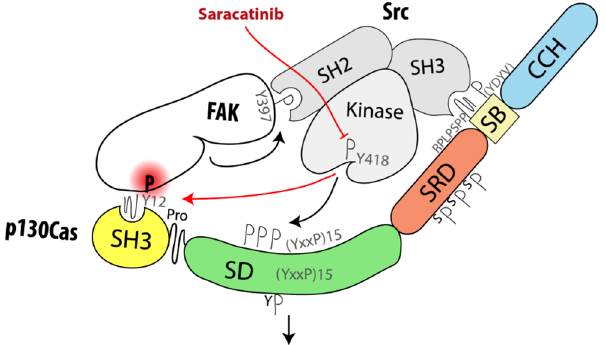
Figure 9. Model of Src-mediated regulation of CAS-FAK association. Upon activation, Src associates with both FAK and CAS through its SH2 and SH3 domains, respectively. This brings Src kinase domain into close contact with CAS SD, leading to its phosphorylation and activation of downstream signaling. With lower dynamics 13 , Src also phosphorylates Tyr12 (Y12) within CAS SH3 domain, which prevents its further binding to FAK and potentially leads to dissociation of the ternary CAS-FAK-Src complex. In contrast, when Src kinase is inhibited, the formation/stabilization of the ternary complex is